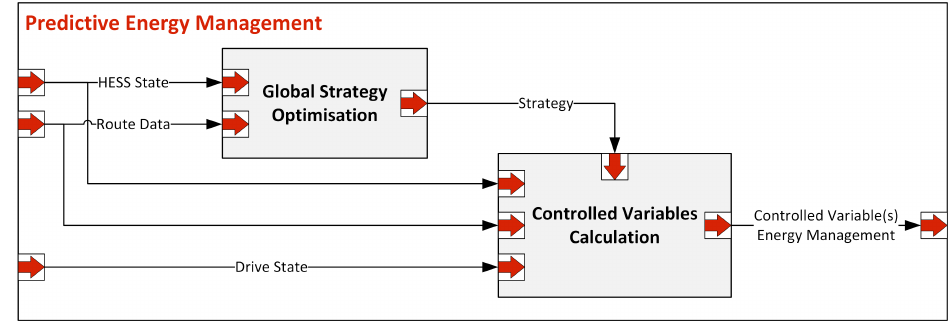
Figure 3. Concept for predictive energy